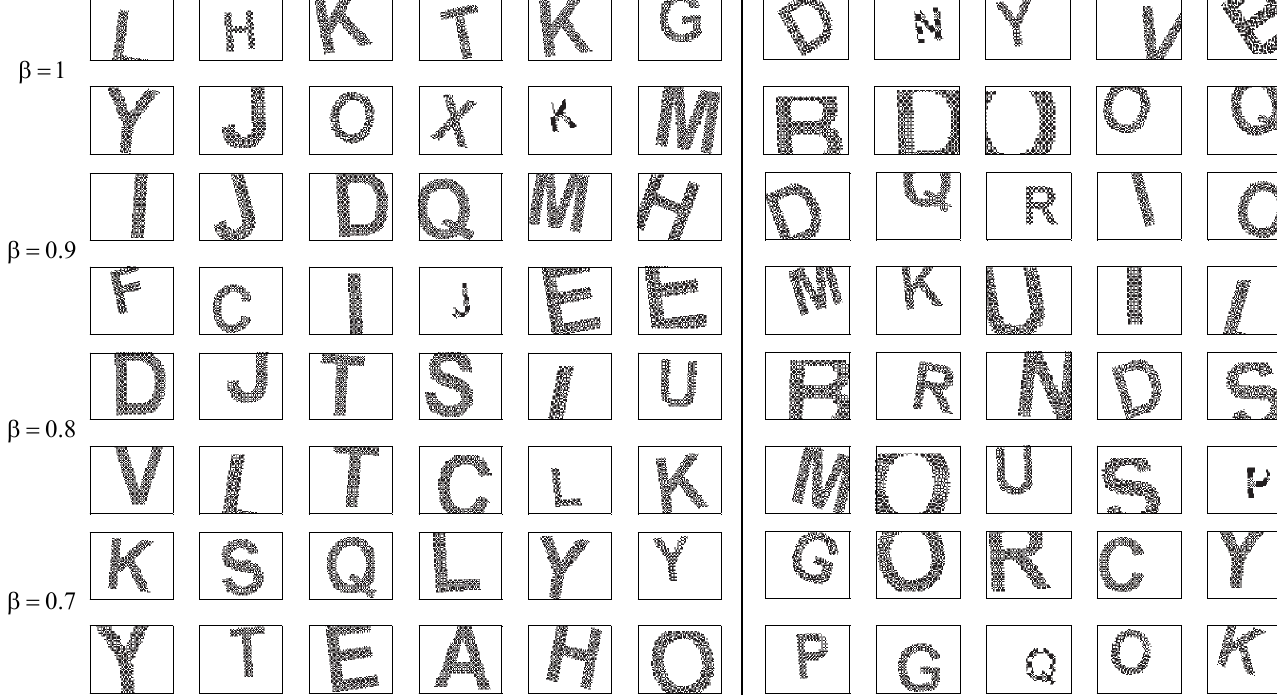
Fig. 6. STSM6080Is of EEACLs classified incorrectly (the right-side images) and classified successfully (the left-side images) by the best 438AP further-trained 2LP. The misclassified images appear so much distorted that the classifier cannot properly “see” them. Seemingly, bad shifting has the worst influence on the